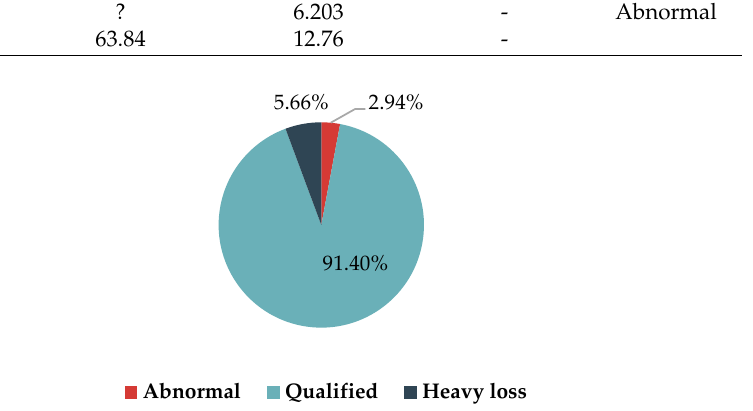
Figure 9. Analysis on prediction